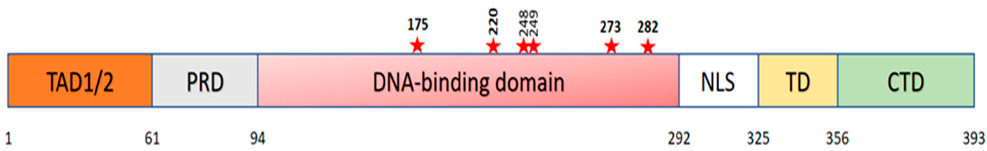
Figure 5. Structure of p53 protein showing the different domains and hot spots (red stars) mutations occurring in human cancer. The 393 amino-acid p53 protein is depicted from the amino-terminus (1) to the carboxy-terminus (393) with boundaries for various domains shaded with different colors: transactivation domain (TAD1/2), proline-rich domain (PRD), DNA-binding domain (DBD), nuclear localization signal (NLS), tetramerization domain (TD), C-terminal domain (CTD). Within this region, the most frequent mutations, are divided into two categories: (1) “conformational mutations”, such as Arg-175-His (p.R175H), Tyr-220-Cys (p.Y220C), Gly- 245-Ser (p.G245S) and Arg-249-Ser (p.R249S), which lead to structural changes in the binding domain, and (2) “contact mutations”, such as Arg-248-Gln (R248Q), Arg-273-His (R273H) and Arg-282-Trp (R282W), which alter the ability of the protein to bind DNA